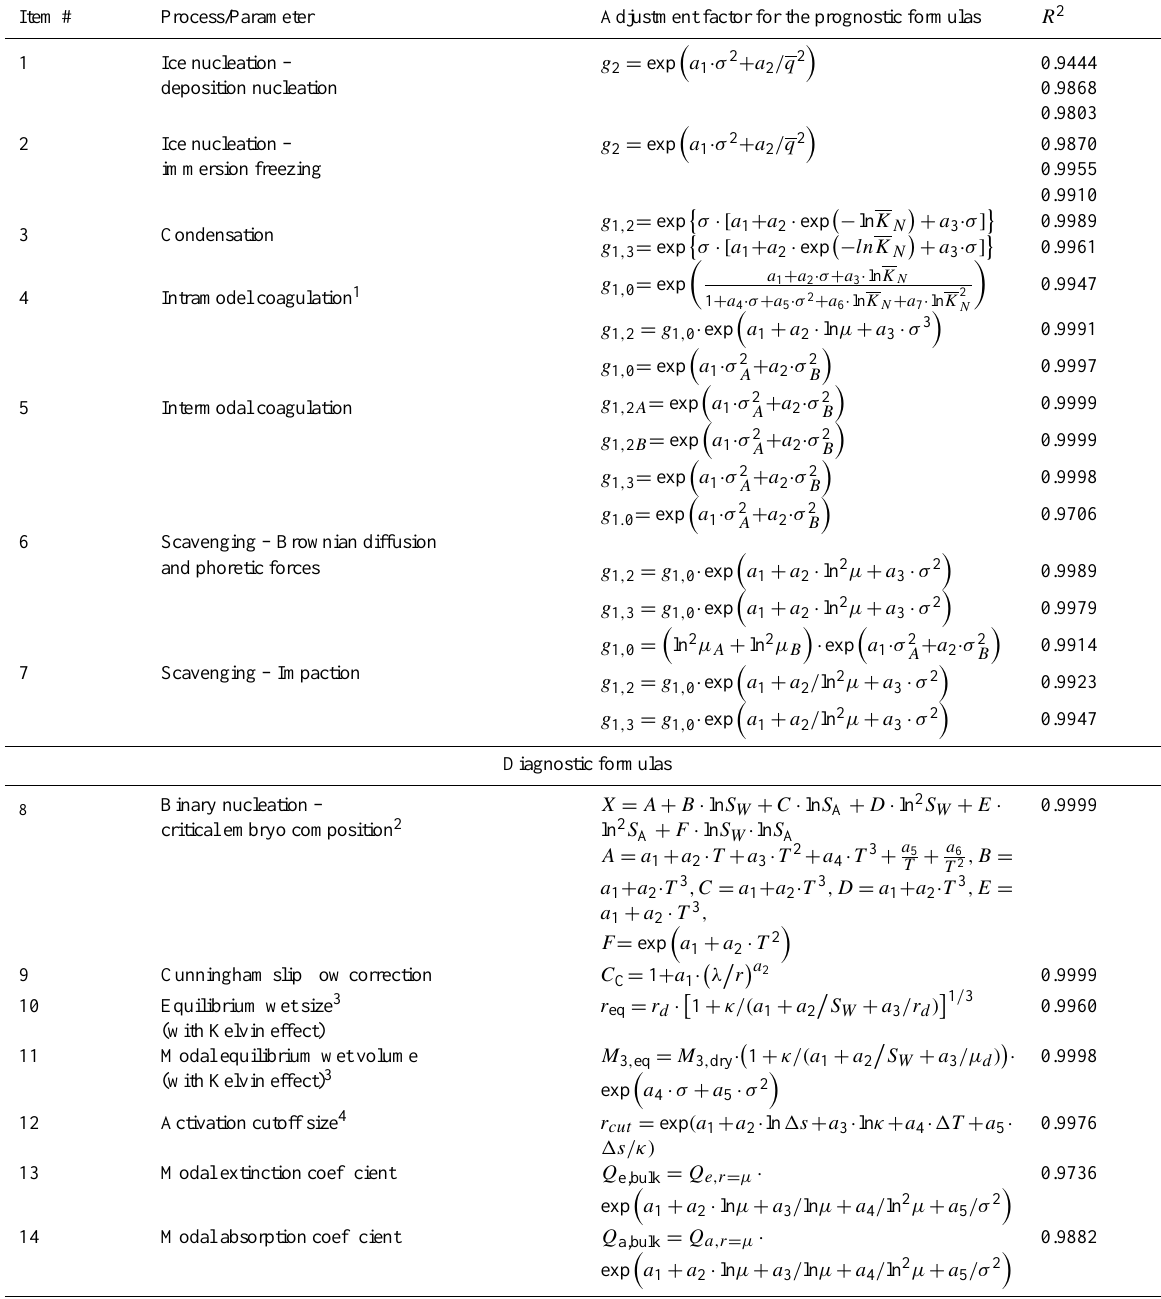
Table A1. Formulas for